Question: Condense the content of this figure into a single sentence.
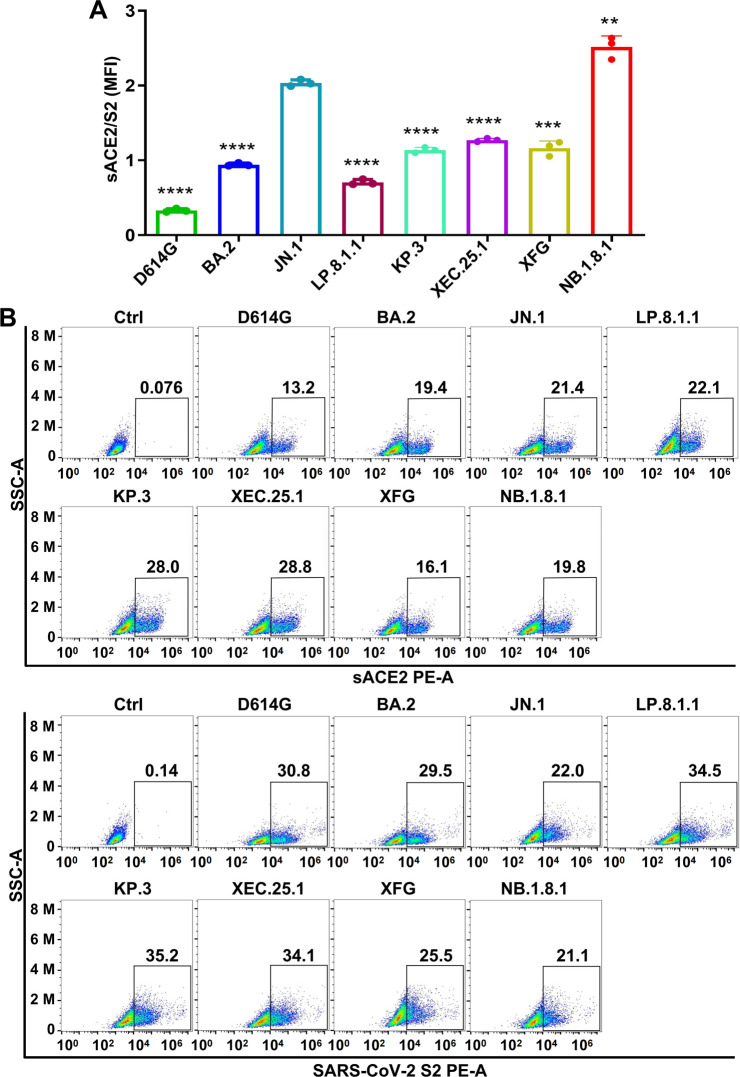
Answer: Evaluation of SARS-CoV-2 spike-binding affinity for soluble ACE2. ( A ) Comparison of binding affinity between spike proteins of emerging JN.1 subvariants and soluble ACE2. Binding affinity was measured by mean fluorescence intensity (MFI), normalized to spike expression levels (sACE2/S2), and weighted according to the proportion of positive cells. All statistical analyses were performed with the JN.1 variant as the reference. The experiments were performed with three technical replicates and repeated at least twice. Data from one representative experiment were presented as the mean ± SD. Statistical analysis utilized two-tailed Student’s t -tests, and P values are indicated as * P < 0.05, ** P < 0.01, *** P < 0.001, **** P < 0.0001. ( B ) Flow cytometry plots of the binding affinity between the JN.1 subvariant spike and soluble ACE2. 293T cells expressing the variant spikes were incubated with Fc-tagged recombinant soluble human ACE2. Fc-tagged proteins were detected using a PE-conjugated anti-human IgG Fc secondary antibody.